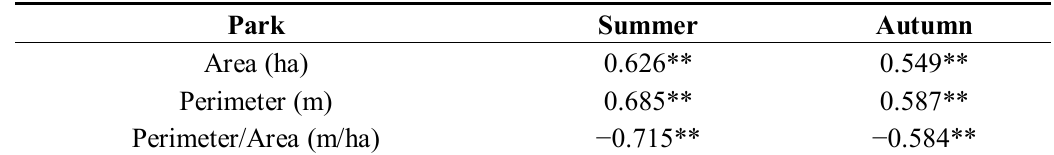
Table 3. Pearson correlation coefficients between PCI and park size in different seasons ( n = 33, p < 0.01).